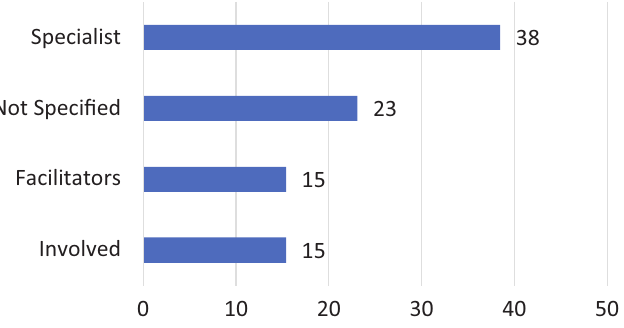
Figure 5. Percentage of studies by samples.